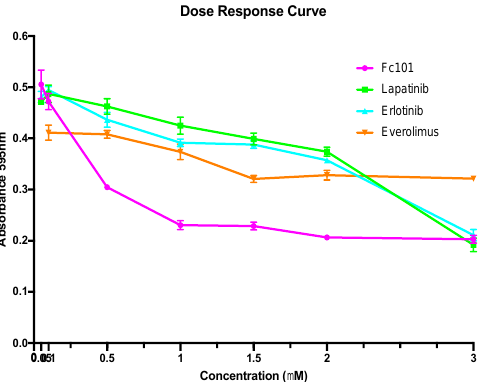
Figure 2. Crystal violet assay dose – response curve, 48 h post drug treatment. The drug panel in- cluded FC101, lapatinib, erlotinib, and everolimus at concentrations of 0 μM, 0.05 μM, 0.1 μM, 0.5 μM, 1.0 μM, 1.5 μM, 2 μM, and 3 μM. The graph represents the normalized color intensity A 595 (% control) vs. the drug concentration.